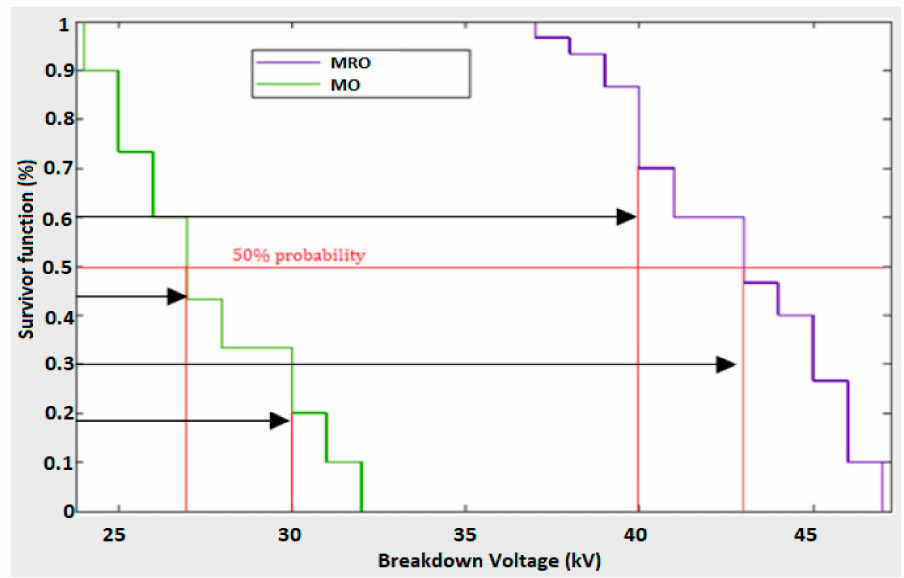
Figure 3. Survival function showing the cumulative distribution of MRO and MO, for any positive number “T” surviving over the time